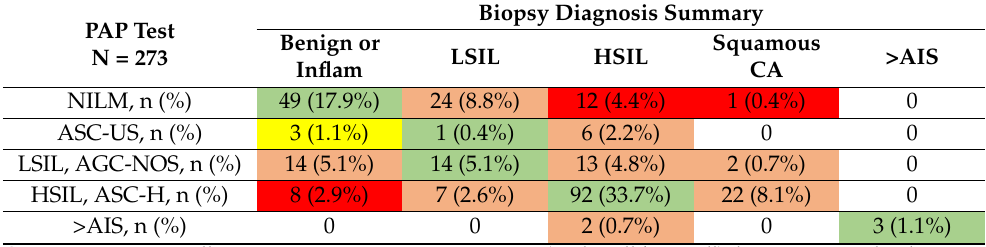
Table 3. Discrepancy assessment grid (over- and undercall refer to the cytology interpretation). Biopsy Diagnosis Summary PAP Test Benign or LSIL N = 273 Inflam